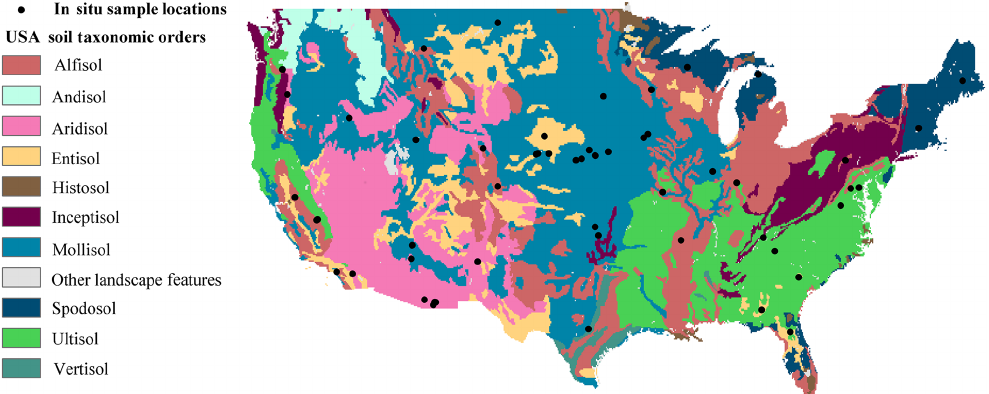
Figure 1. Map of soil taxonomic classification over the continental USA using the 12 US soil taxonomic orders (data source: United Nations, 2007), and M. Kuzila, personal communication, 2014). Note Gelisols are not present in the CONUS. Black dots indicate 61 locations where we have in situ composite/average samples for soil bulk density, soil lattice water, soil organic carbon, and clay weight fraction collected over a 12.6ha circle and averaged over the top 30cm (Table S1 in the